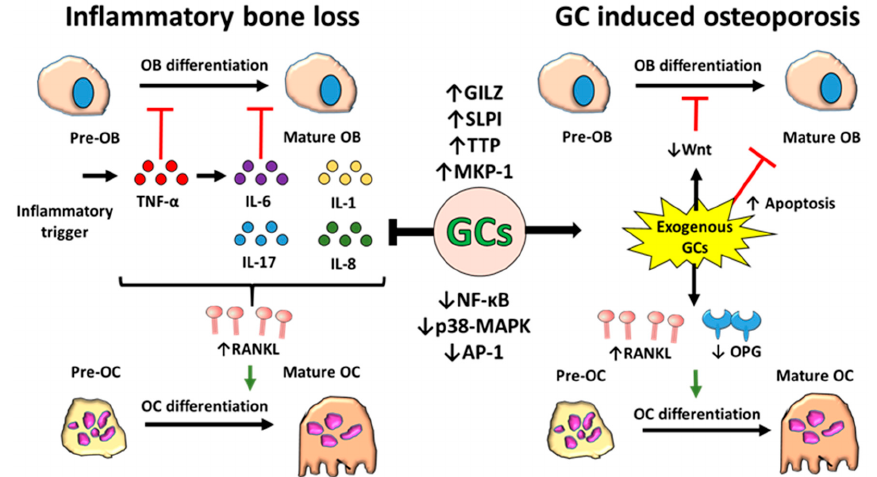
Figure 2. Schematic representation of the effects of inflammation and glucocorticoids (GCs) on bone remodelling. During inflammation, elevated levels of pro-inflammatory cytokines, such as TNF- α and IL-6, inhibit the differentiation of bone forming osteoblasts from their precursors. These cytokines, along with other pro-inflammatory mediators including IL-1, IL-17 and IL-8, also upregulate the expression of receptor activator of nuclear factor kappa- Β ligand (RANKL), which binds to receptor activator of nuclear factor kappa- Β (RANK) on pre-osteoclasts and triggers their differentiation into mature bone resorbing osteoclasts. Overall, bone formation is decreased while bone resorption is increased, leading to a net loss of bone. Although GCs suppress inflammation via suppression of pro-inflammatory factors and induction of anti-inflammatory mediators, they can also independently drive bone loss by inhibiting di ff erentiation and inducing apoptosis of osteoblasts whilst increasing osteoclast di ff erentiation by stimulating expression of RANKL and decreasing its decoy receptor osteoprotegerin (OPG). Osteoblasts (OBs), p38 mitogen-activated protein kinases (p-38-MAPK), glucocorticoid-induced leucine zipper (GILZ), secretory leukocyte protease inhibitor (SLPI), tristetraprolin (TTP), mitogen-activated protein kinase-1 (MKP-1), activator protein 1 (AP-1), OC (osteoclast), canonical WNT signalling (WNT), and nuclear factor kappa-light-chain-enhancer of activated B cells (NF- κ